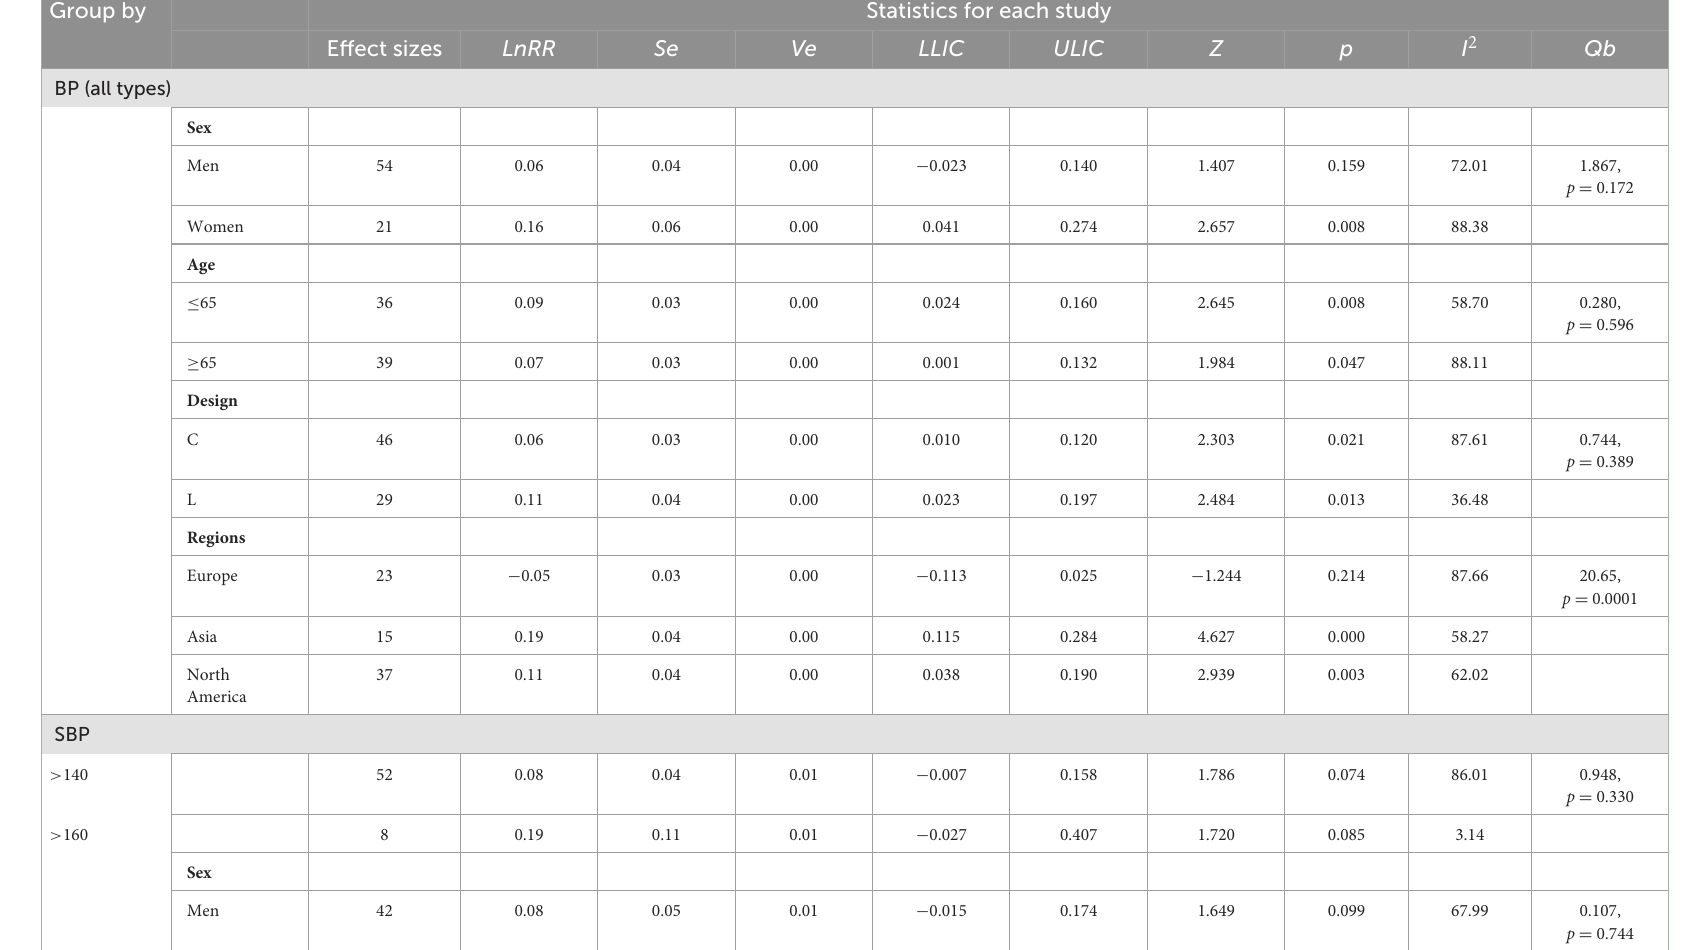
TABLE 5 Effects of sex, age, design, and regions in different types of SBP ( > 140 and > 160 mmHg) and DBP ( > 85 and > 90 mmHg). Group by Statistics for each